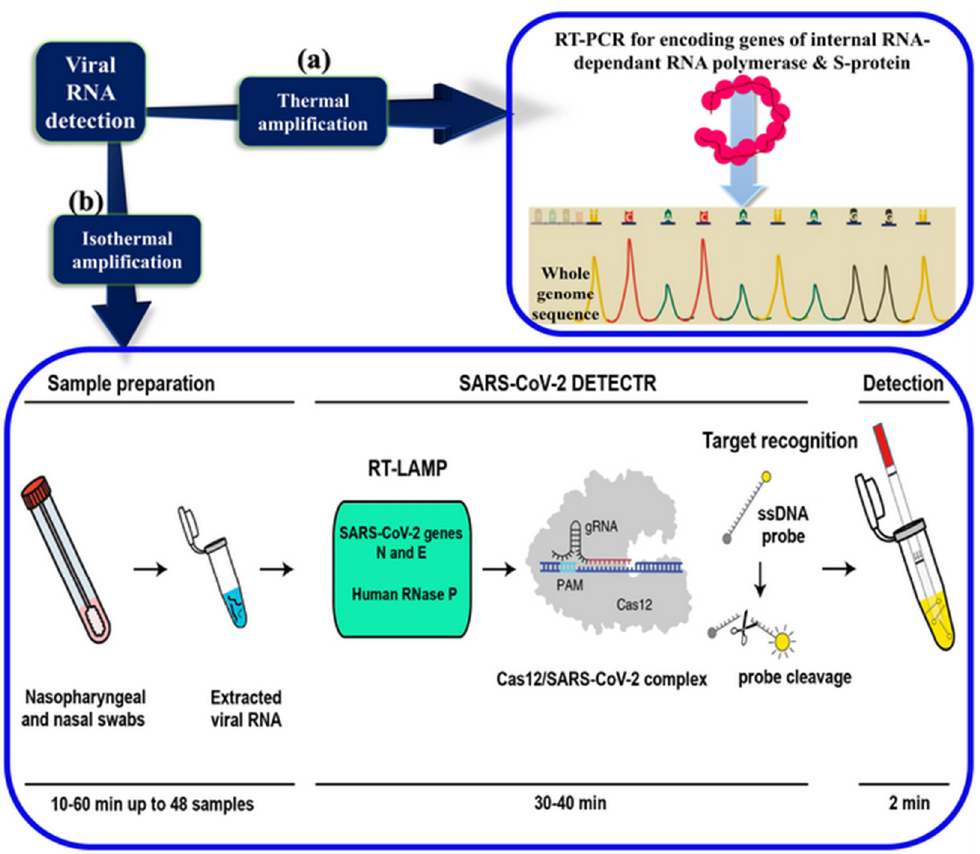
Figure 5. COVID-19 molecular diagnostic methods. ( a ) Virus molecular characterization by RT-PCR Figure 5. COVID‐19 molecular diagnostic methods. ( a ) Virus molecular characterization by RT‐PCR and whole-genome sequencing, ( b ) development of the CRISPR-Cas12 in the virus detection via the and whole‐genome sequencing, ( b ) development of the CRISPR‐Cas12 in the virus detection via the isothermal amplification of the viral isothermal amplification of the viral genome.